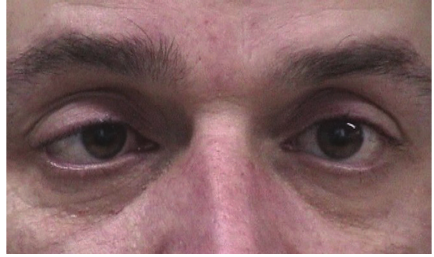
Figure 9: Full abduction of right eye on